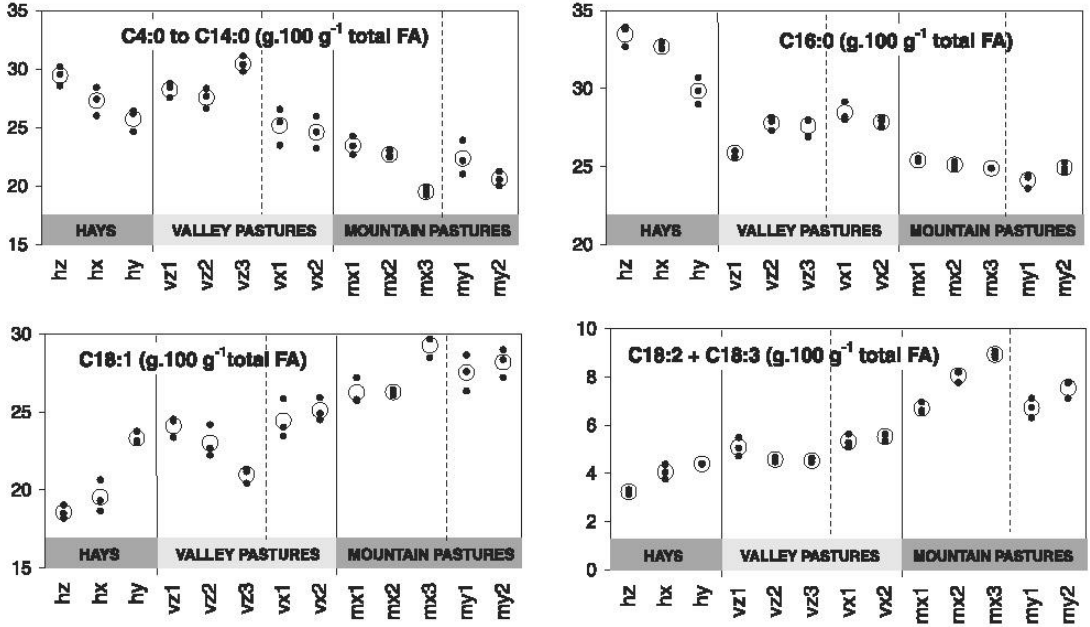
Figure 3. Effect of botanical composition on milk fatty acid (FA) composition of cows. Legend: x, y, z = farms, h = hay, v = valley pasture, m = mountain pasture, 1–3 = date of sampling [14].